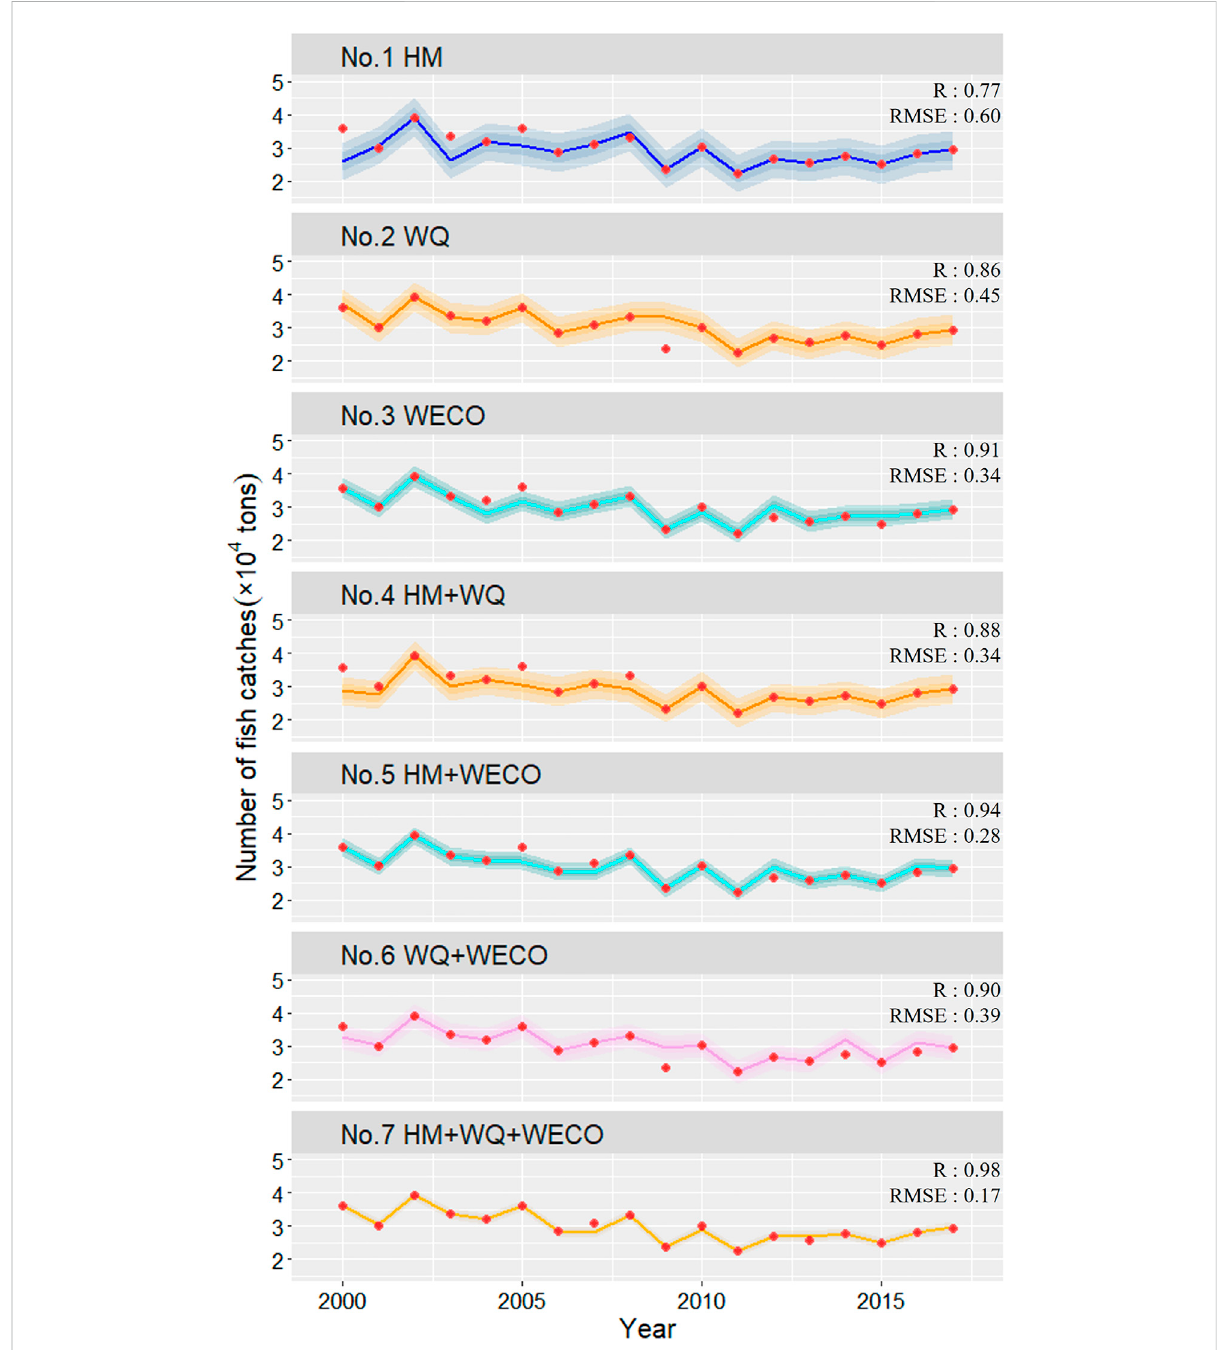
FIGURE 7 Simulation results based on the combination of hydrometeorological conditions, water quality, and ecological variables.